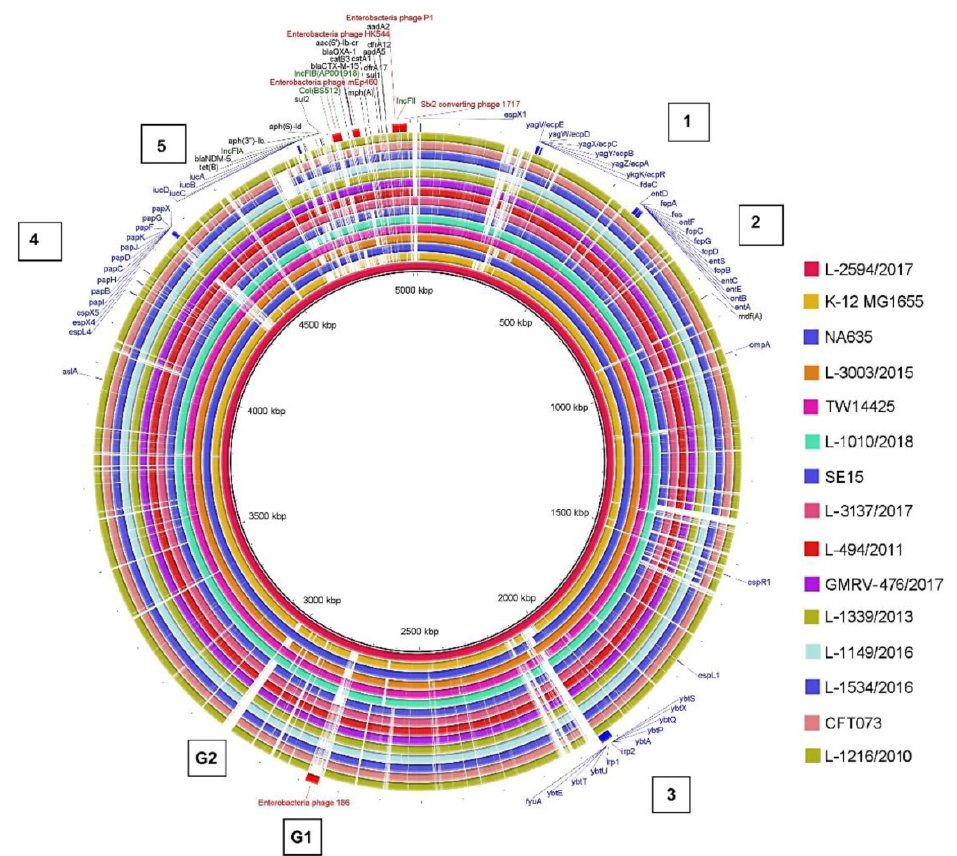
Figure 1. Comparison of ocular E. coli genomes and reference genomes of di ff erent phylogenetic groups. Ocular isolate L-2594 / 2017 was used as a reference. In the outermost ring, blue, black, red, and green indicate virulence genes, resistance genes, phages, and plasmids, respectively. Numerals 1 to 5 indicate the five clusters of virulent genes. BLASTn matches with less than 30% identity appear as blank spaces (gaps) in each ring. G1 and G2 indicate the gaps in the genomes. The image was prepared using